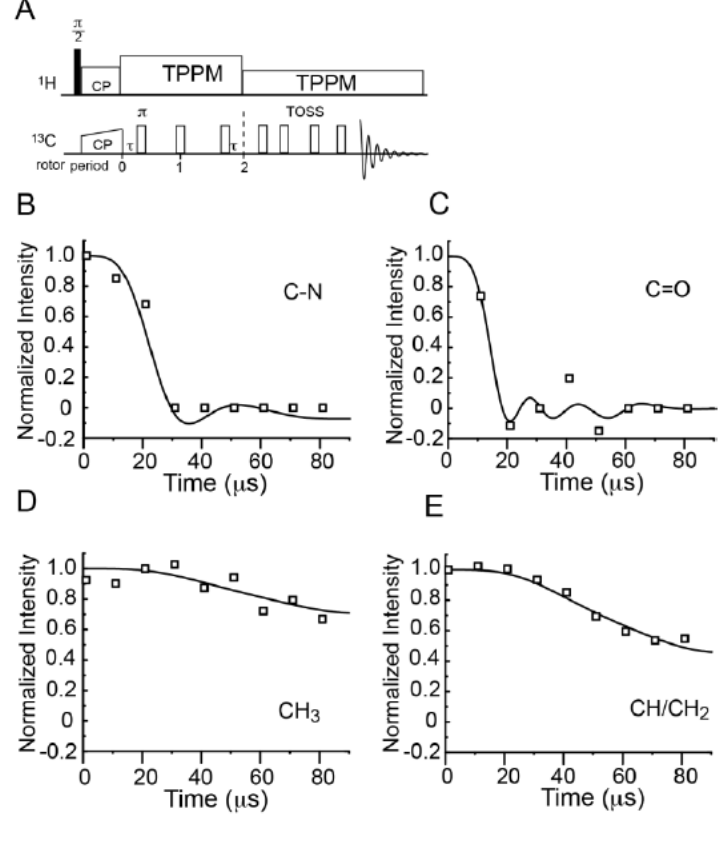
and ( D ) CH/CH . 3 2